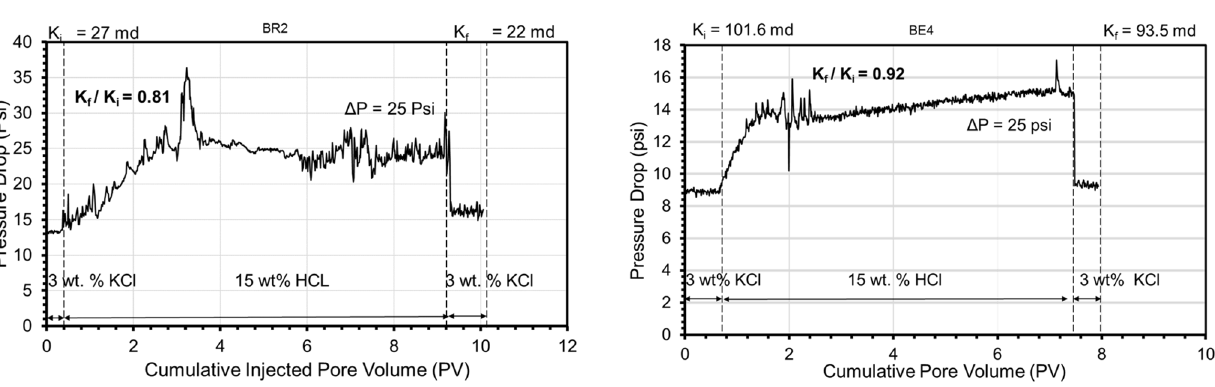
Fig. 3 Pressure drop across the sample Berea sandstone (BE3) as the deionized water injected at 5 cm 3 /min (backpressure = 1000 psi, con- fining pressure = 1700 psi)